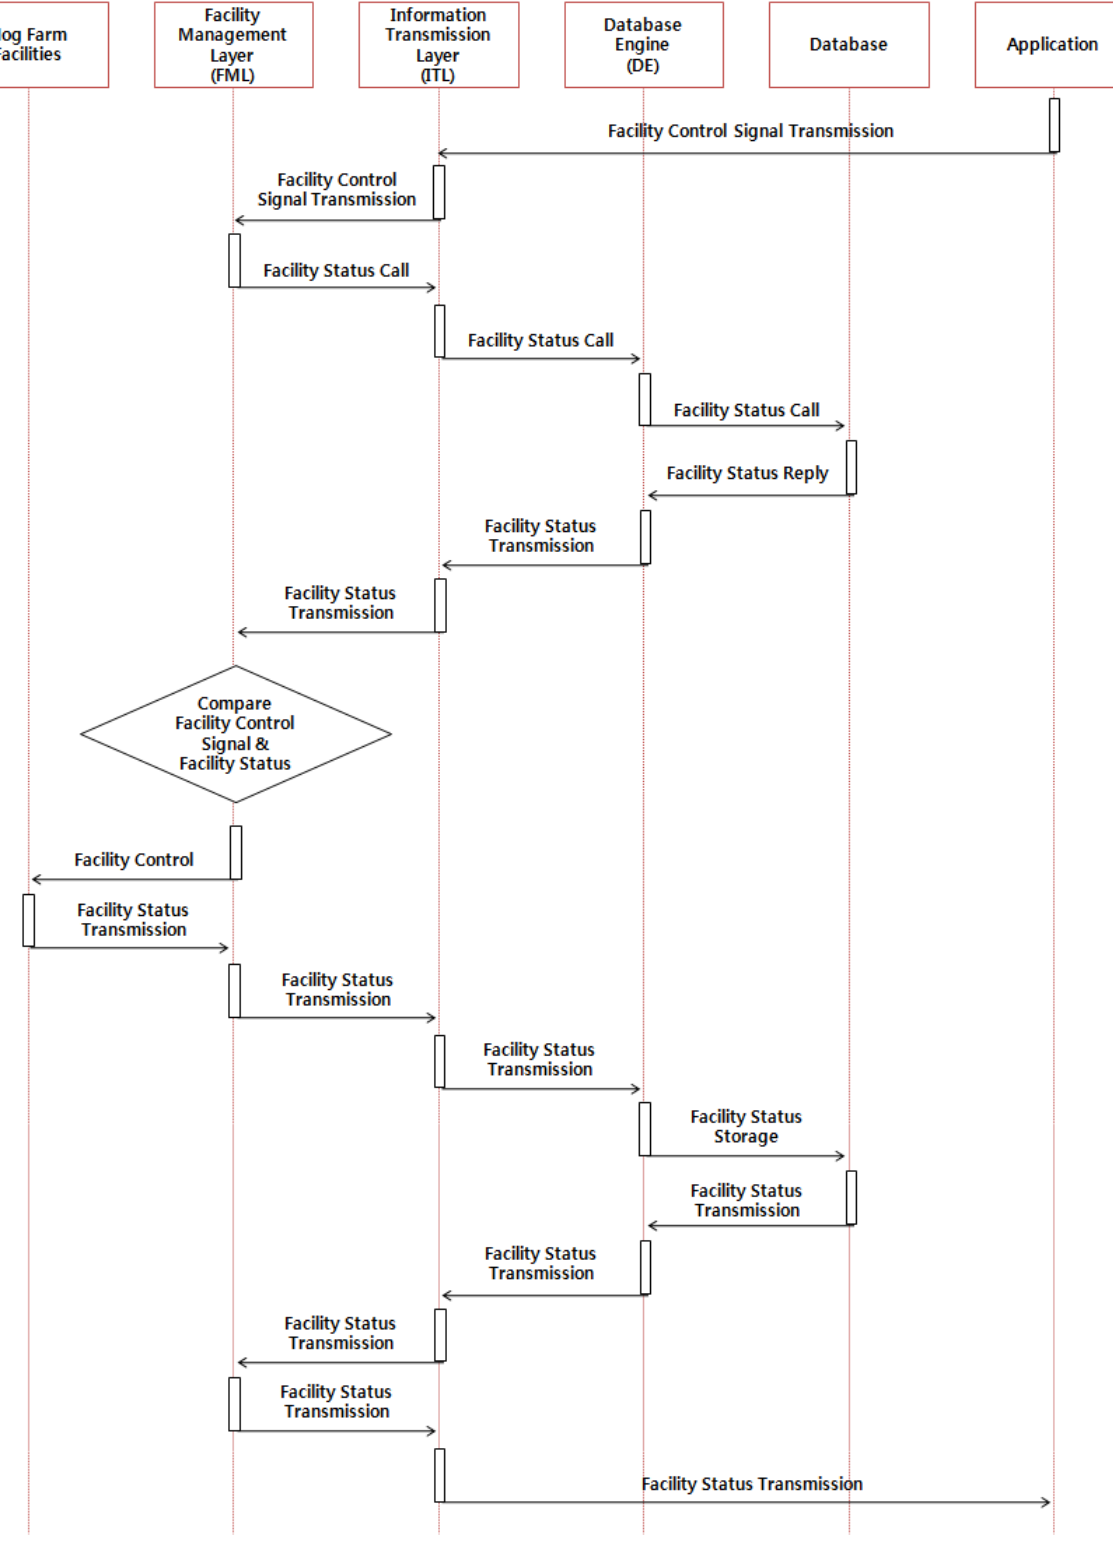
Figure 6. Operation of the Hog Farm Facility Manual Control